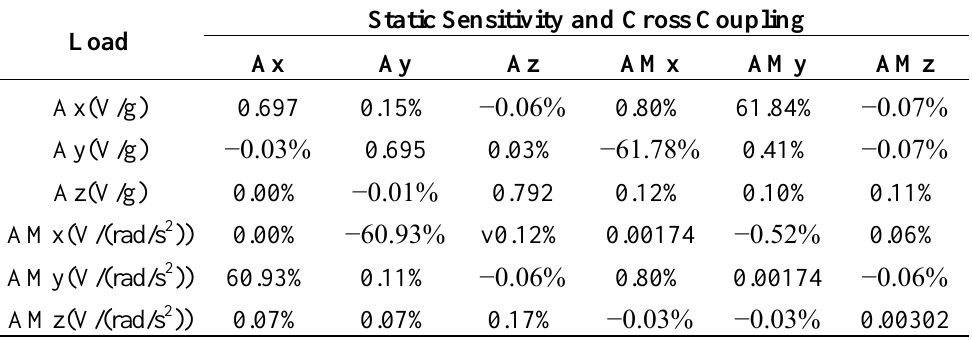
Table 2. Simulation results of static sensitivity and cross coupling.